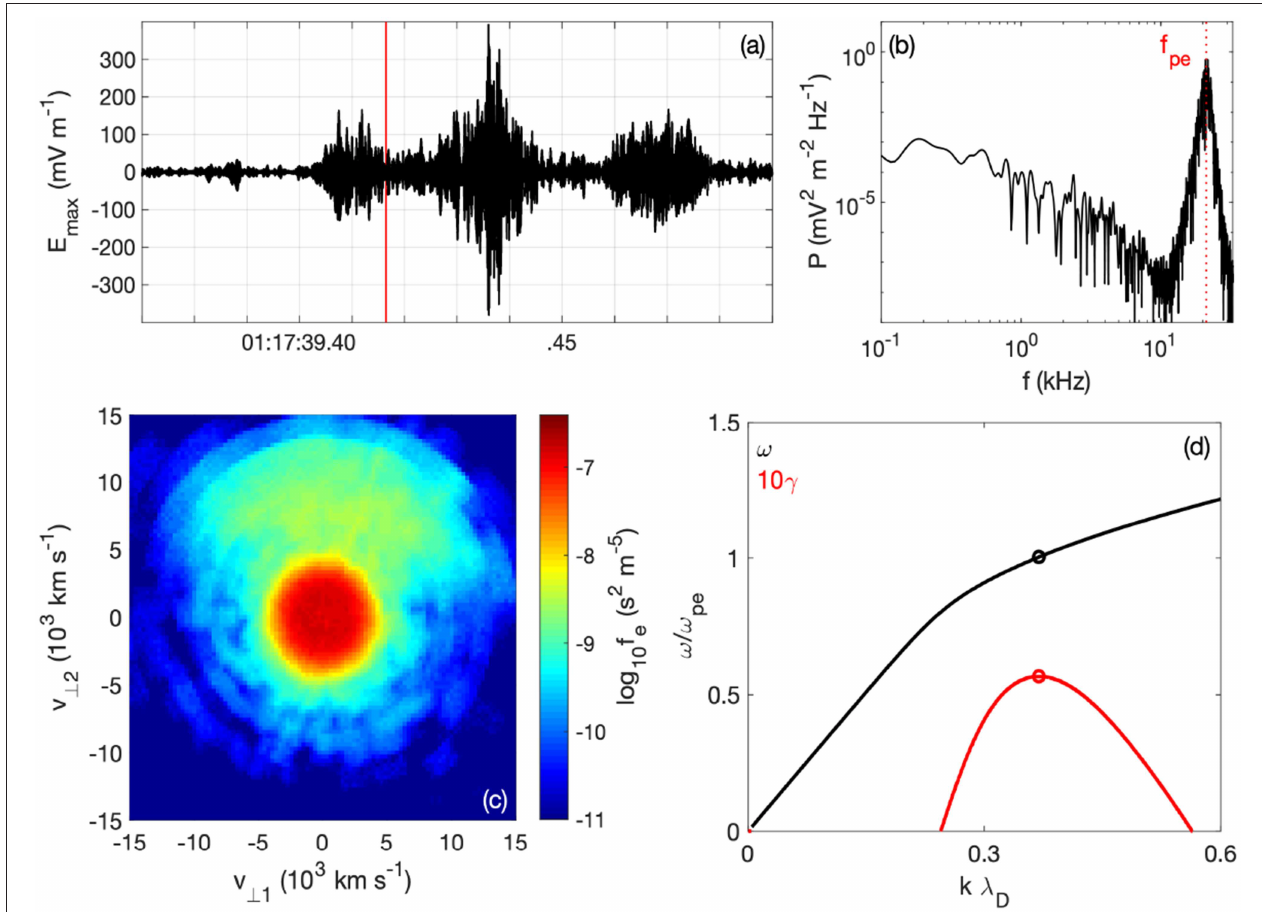
FIGURE 3 | Example of UH waves observed near an EDR at Earth’s magnetopause observed by MMS1 from Graham et al. (2017a). (a) Waveform of UH waves. (b) Power spectrum. (c) Two-dimensional reduced distribution in the plane perpendicular to the local magnetic field. (d) Dispersion relation (black) and growth rate (red) predicted by linear